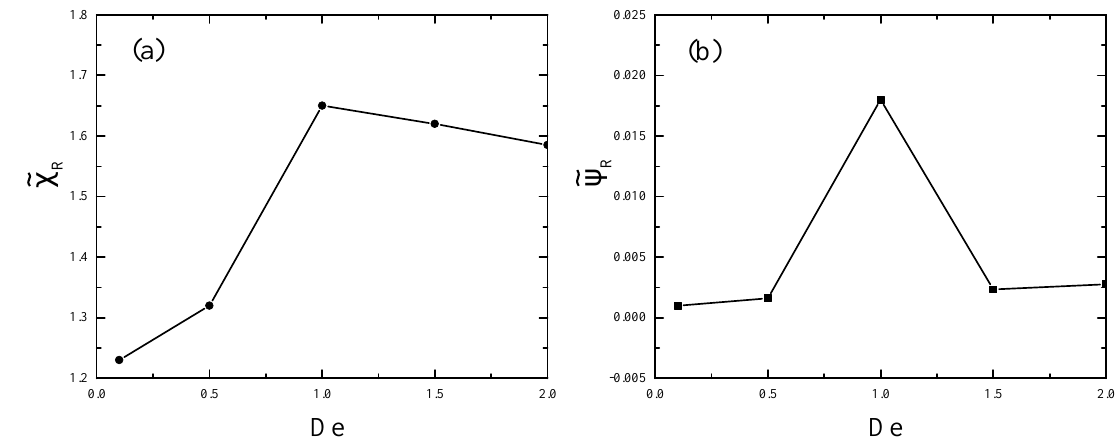
Figure 4. ( a ) Corner vortex size normalized by characteristic height H and ( b ) corner vortex intensity normalized by U out H versus Deborah